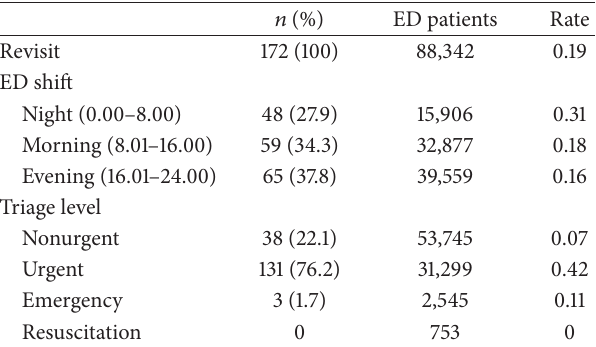
Table 2: Visit characteristics of initial emergency department visit, 𝑛 = 172 .